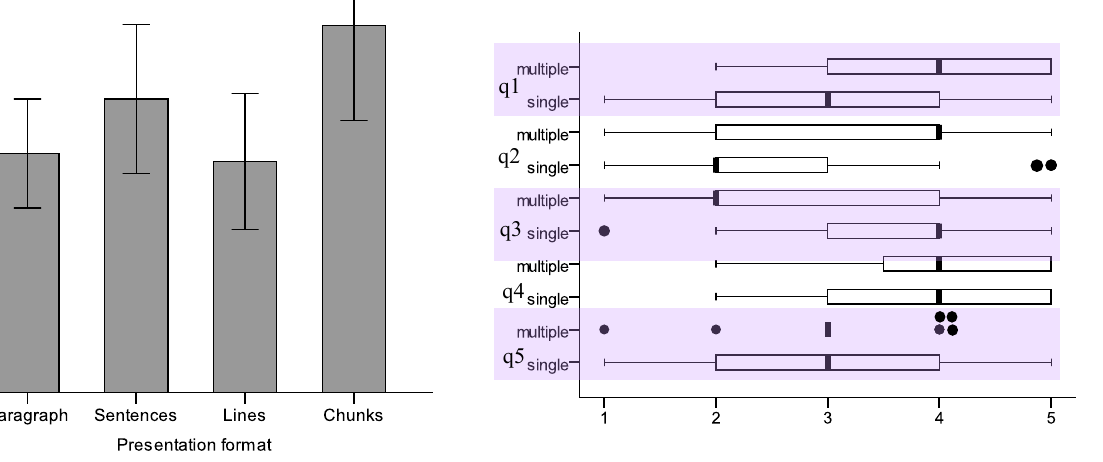
Figure 4: Number of regressions with different presenta- tion formats (manual), with error bars representing the standard error of the mean.